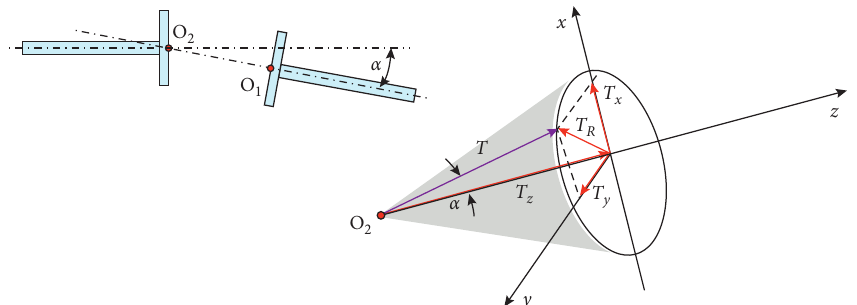
Figure 4: Torque decomposition of coupled shafts in which angular misalignment is present.